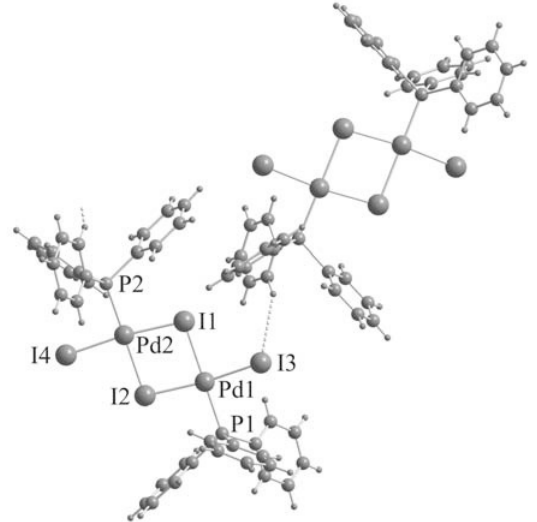
Table 2. Atomic coordinates and displacement parameters (in Å 2 )